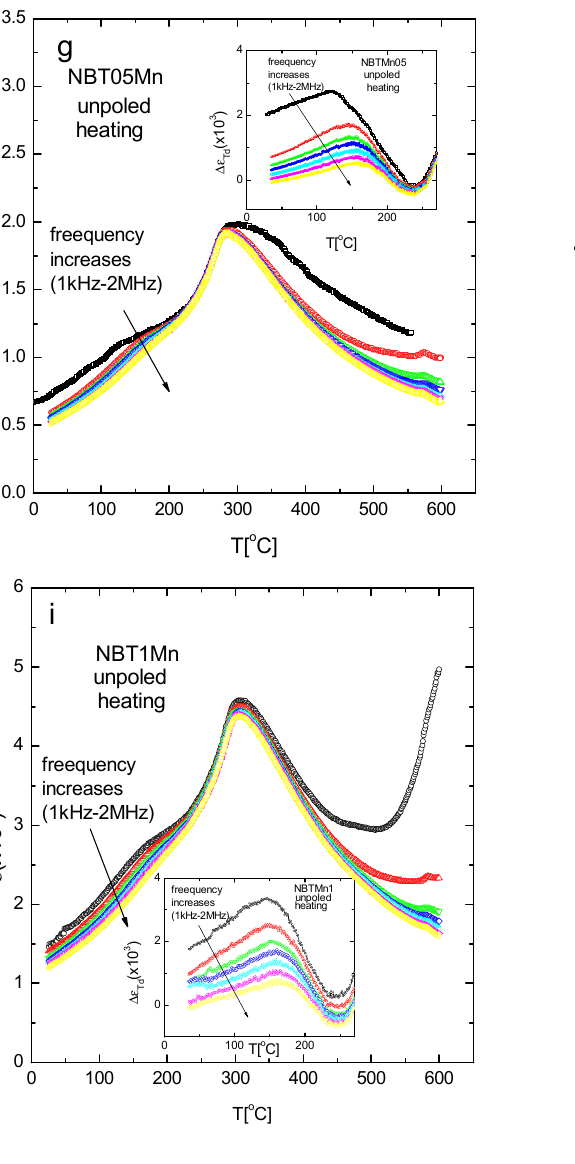
Figure 4. Variation of the permittivity temperature of the tested samples in polar and non-polar states. NBT without pole ( a ) with pole ( b ), NBT05Mn without pole ( c ) with pole ( d ), NBT1Mn without pole Figure 4. Temperature variation in electric permittivity of the investigated samples in unpoled and ( e ) with pole ( f ), NBT05Fe without pole ( g ) with pole ( h ) and NBT1Fe without pole ( i ) with pole ( j ), poled states. NBT unpoled (a) poled (b), NBT05Mn unpoled (c) poled (d), NBT1Mn unpoled (e) (black—1 kHz, red—10 kHz, green—100 kHz, blue—250 kHz, cyan— 500 kHz, magenta—1 MHz, poled (f), NBT05Fe unpoled (g) poled (h) and NBT1Fe unpoled (i) poled (j), (black color-1kHz, red yellow—2 MHz color-10kHz, green color-100kHz, blue color- 250kHz, cyan color 500kHz, magenta color 1MHz, yellow color-2MHz).